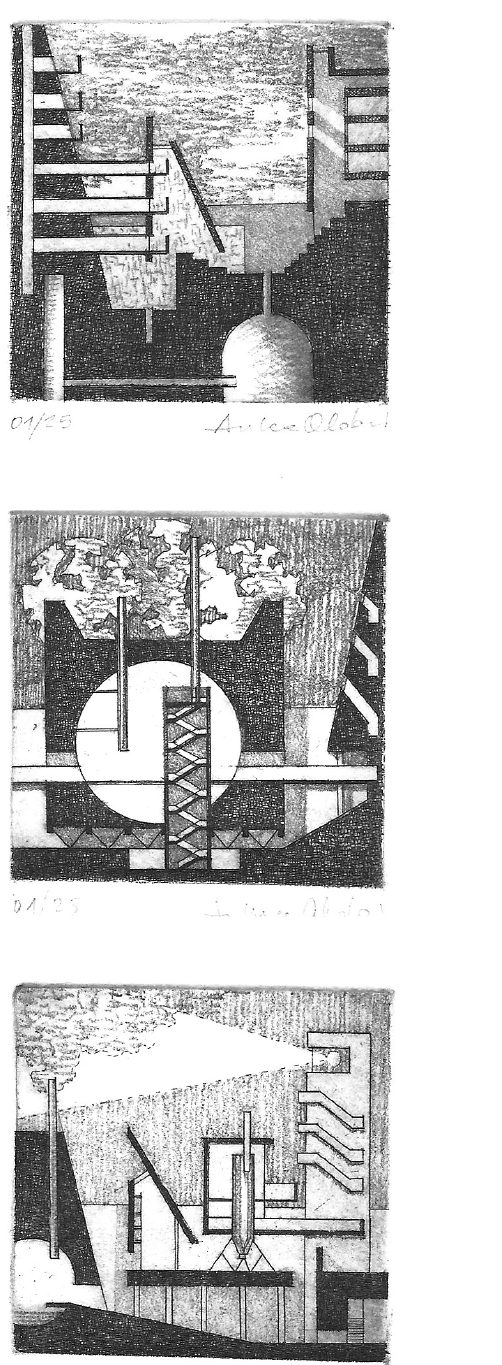
211 www.img-network.it